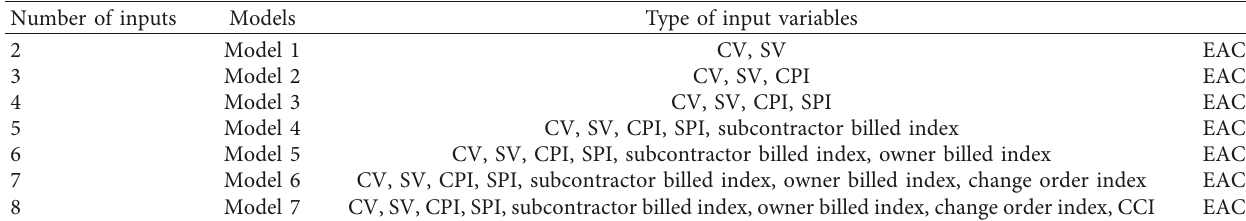
Table 9: The input combination attributes used to determine the value of the EAC using the BF-SVR model. Number of inputs